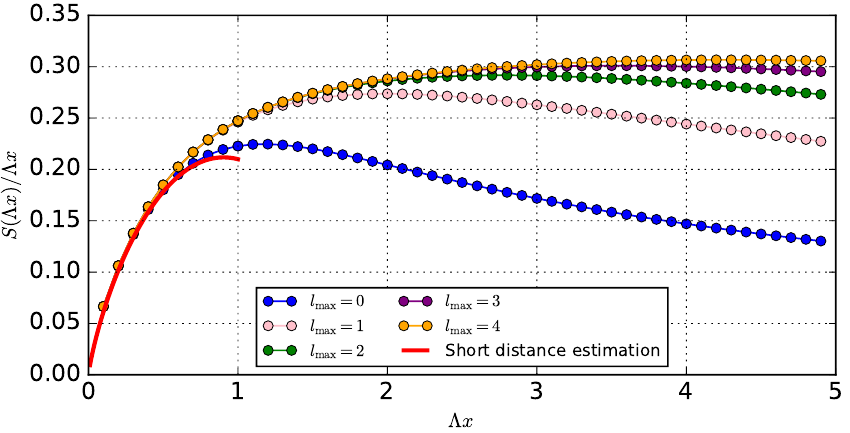
Figure 10 . Numerical computation of the entanglement entropy pro(cid:12)le ((cid:3) a = 0 : 01) for the 2+1 dimensional bosonic cMERA.